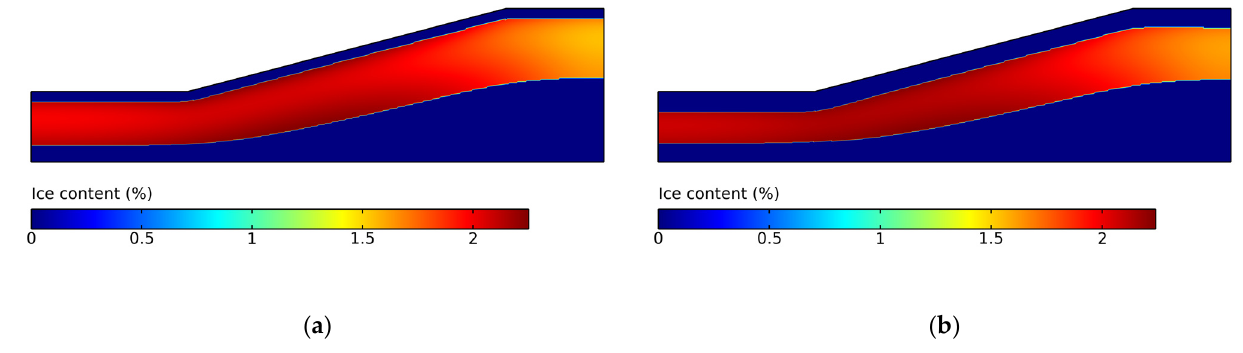
Figure 9. Ice content distribution of the soil at ( a ) 110 h and ( b ) 120 h.